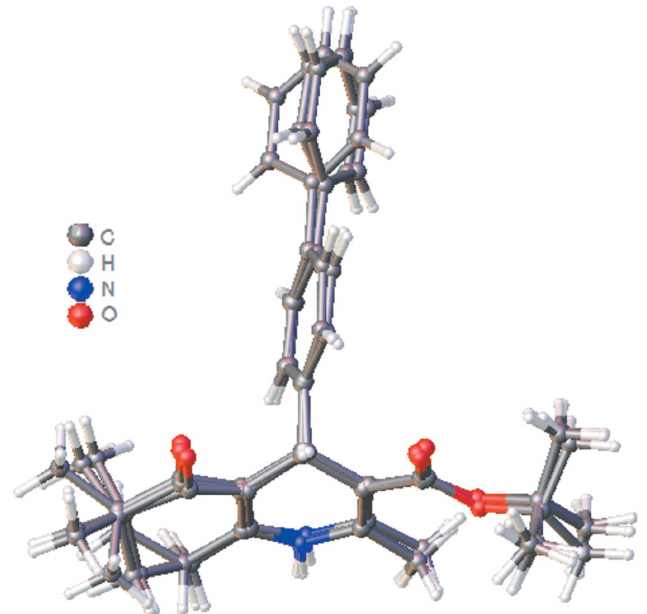
Figure 2 Overlay image of the three independent molecules of the title compound. While the terminal phenyl rings of molecules A and B coincide well, that of molecule C is not in the same plane with them, and is approximately normal to them. Only the major component of the disorder in molecule C is